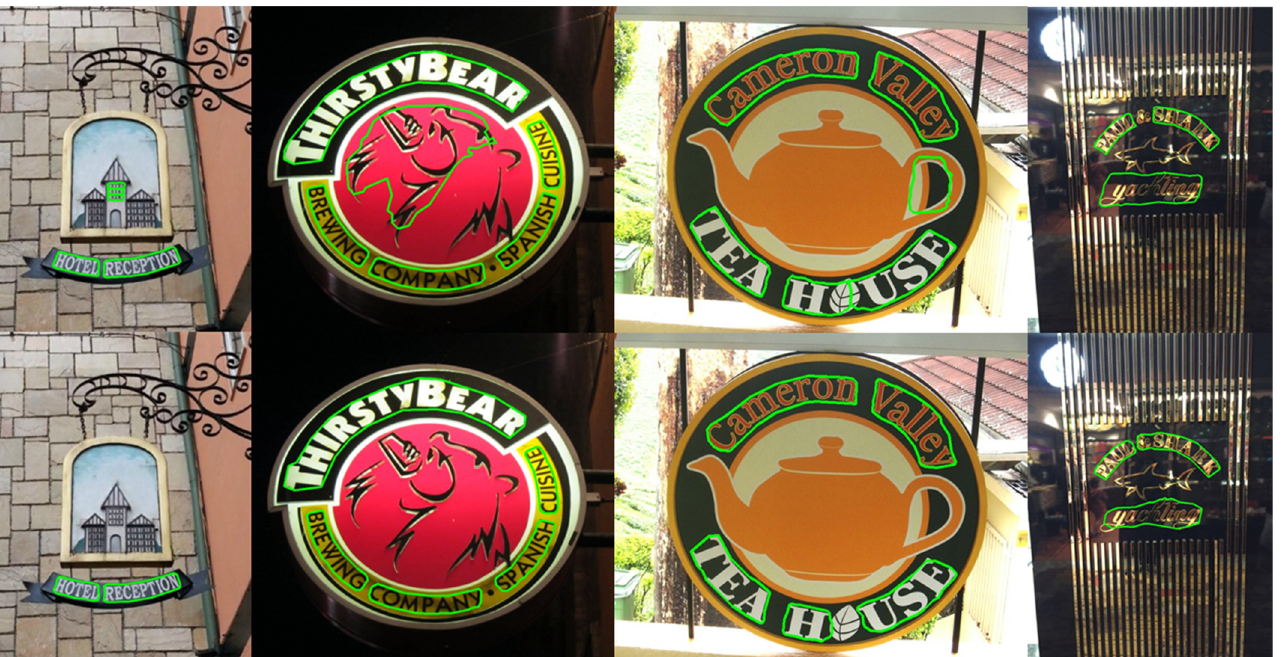
Figure 5. The visualization compares the detection results of our method with other methods when performing text detection in regions similar to text and regions with strong interference. The upper half is the detection results of other methods, which often detect non-text regions as text regions by mistake. The lower half is the detection result of our model, which shows that our model can distinguish text and non-text regions well in this case.